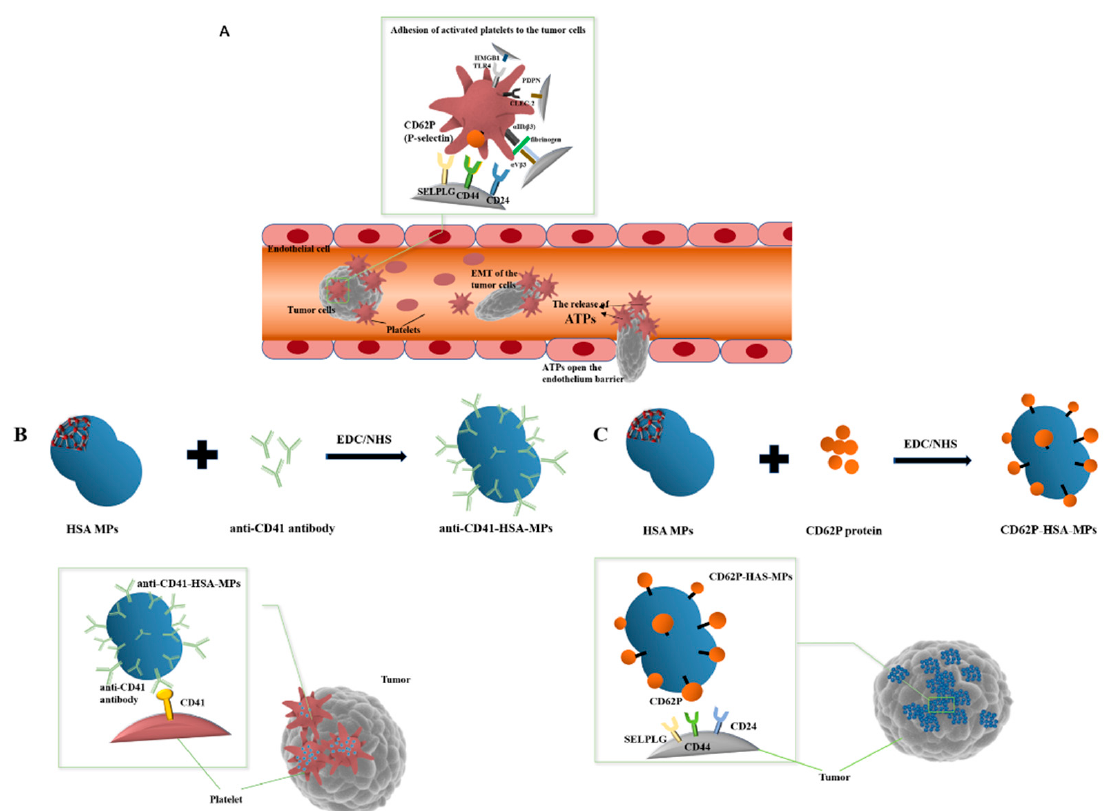
Figure 1. Schematic of targeting strategies. ( A ). Schematic of the circulating tumor cell captured by activated platelets in vivo, adhering and escaping through gaps of the endothelium. ( B ). Anti-CD41- HSA-MPs hitchhiked on platelets to target circulating tumor cells indirectly. ( C ). CD62P-HSA-MPs target a tumor cell directly mediated by the CD62P on the surface of the HSA-MPs.